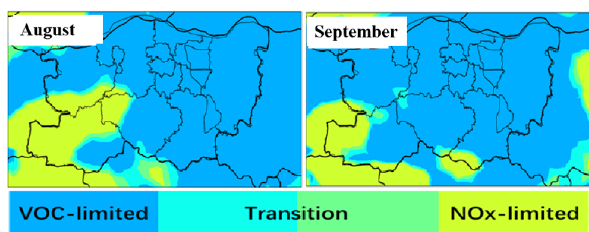
Figure 9. Spatial comparison of the O 3 –NO x –VOC sensitive regime between August and September 2019 in